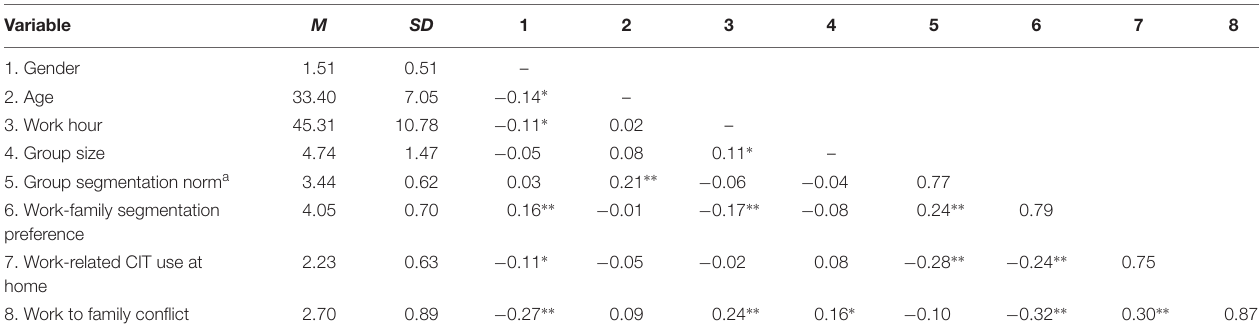
TABLE 1 | Descriptive statistics and